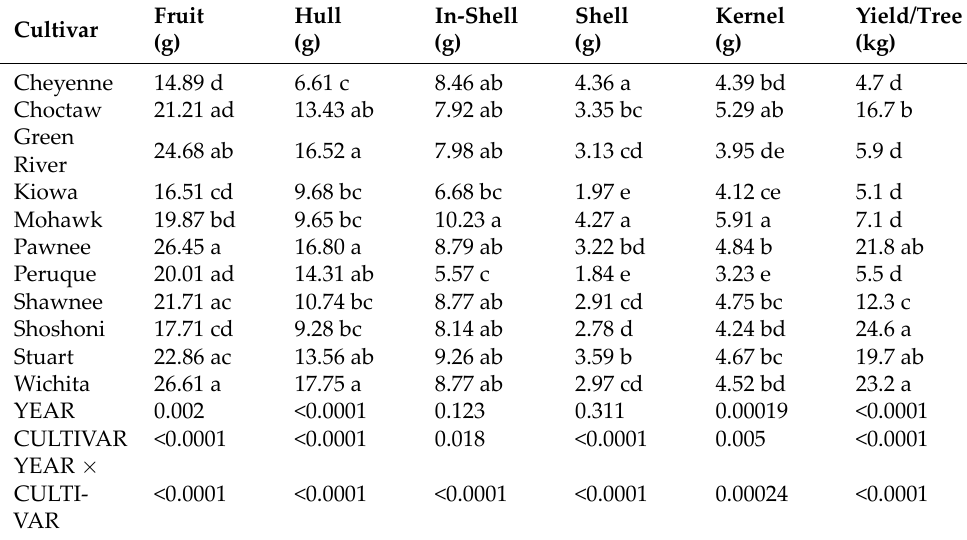
Table 1. Fresh weight of fruit parameters and yield of in‑shell nuts as the average of 2018 and 2019 growing seasons a .